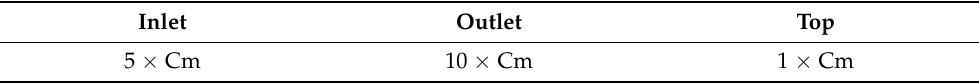
Table 2. Distance of the boundary surfaces in function of C m